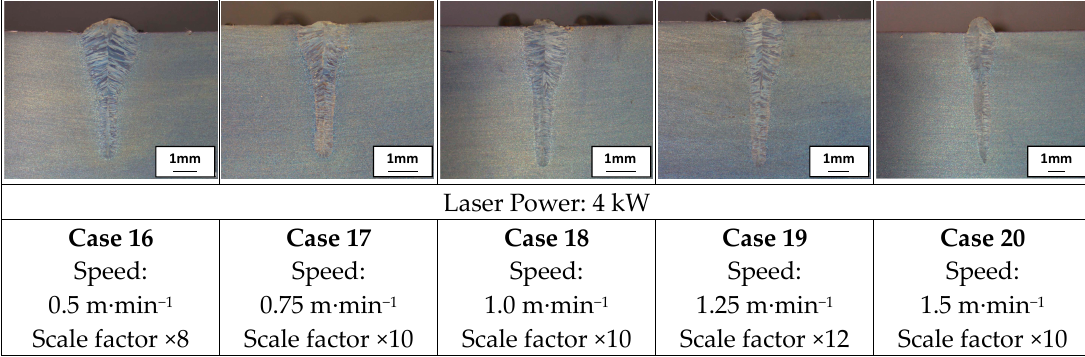
Figure 6. Bead geometry on BOP welding test (laser power: 4 kW, Case 16~20).